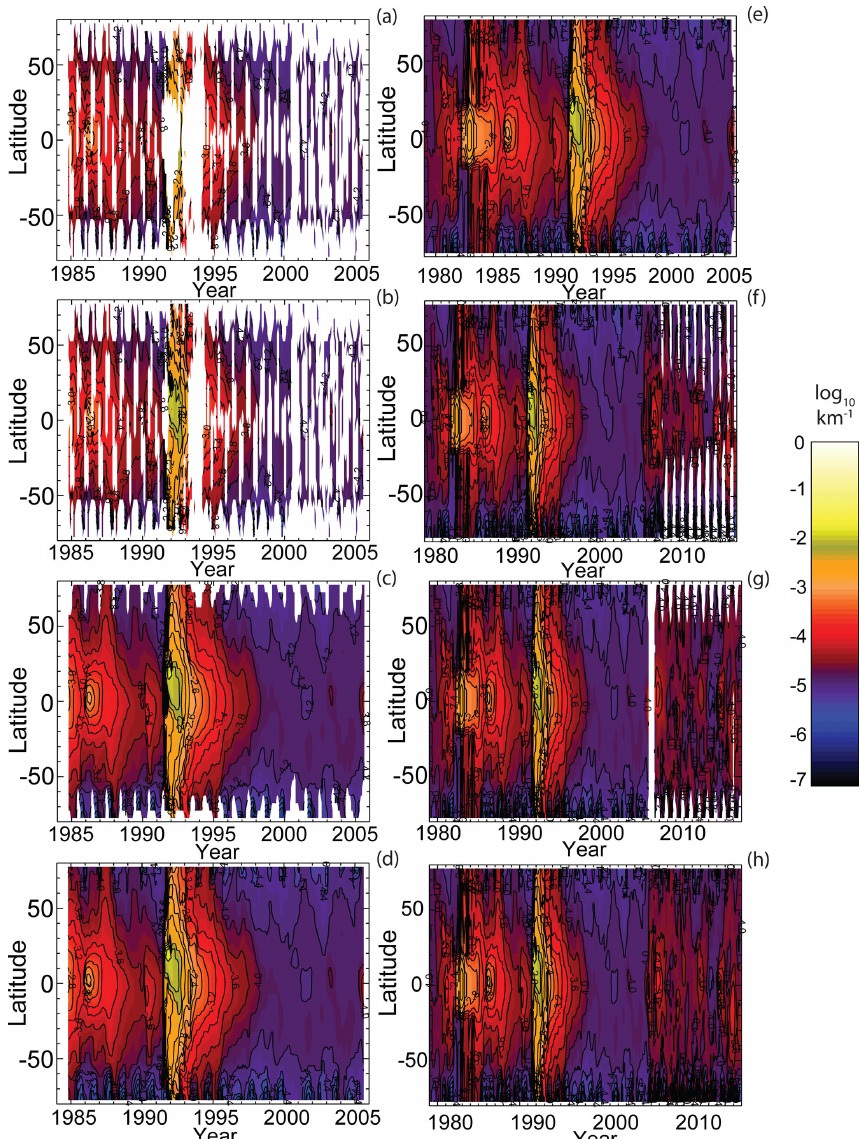
Figure 3. Steps involved in the creation of the GloSSAC 1020nm aerosol extinction coefficient climatology at 21km: (a) 1984–2005 with SAGE II only, no interpolation; (b) with SAGE II, CLAES, HALOE, and ground based-lidar, no interpolation; (c) with interpolation; (d) with high-latitude reconstruction; (e) 1979–2005 with the pre-SAGE II era data from SAGE, SAM II, airborne and ground-based lidar; (f) 1979– 2016 adding only OSIRIS; (g) 1979–2016 adding only CALIPSO; and (h) 1979–2016 adding both OSIRIS and CALIPSO and producing the final product. The plotting software tends to exaggerate white space in the plots particularly in (a) and (b)